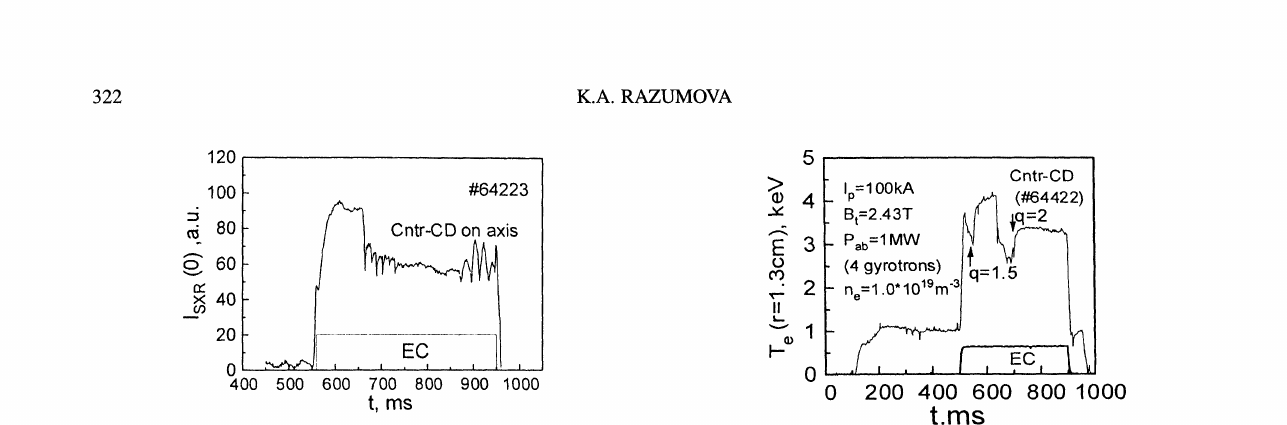
FIGURE 7 T-10 tokamak. Temporal behavior of Te(0) under off axis ECCD in the direction opposite to the main plasma current direction. The periodic confinement increase takes place at the discharge end when qmin approach 2. Internal disruptions with rn 2 are seen at the beginning of the discharge.